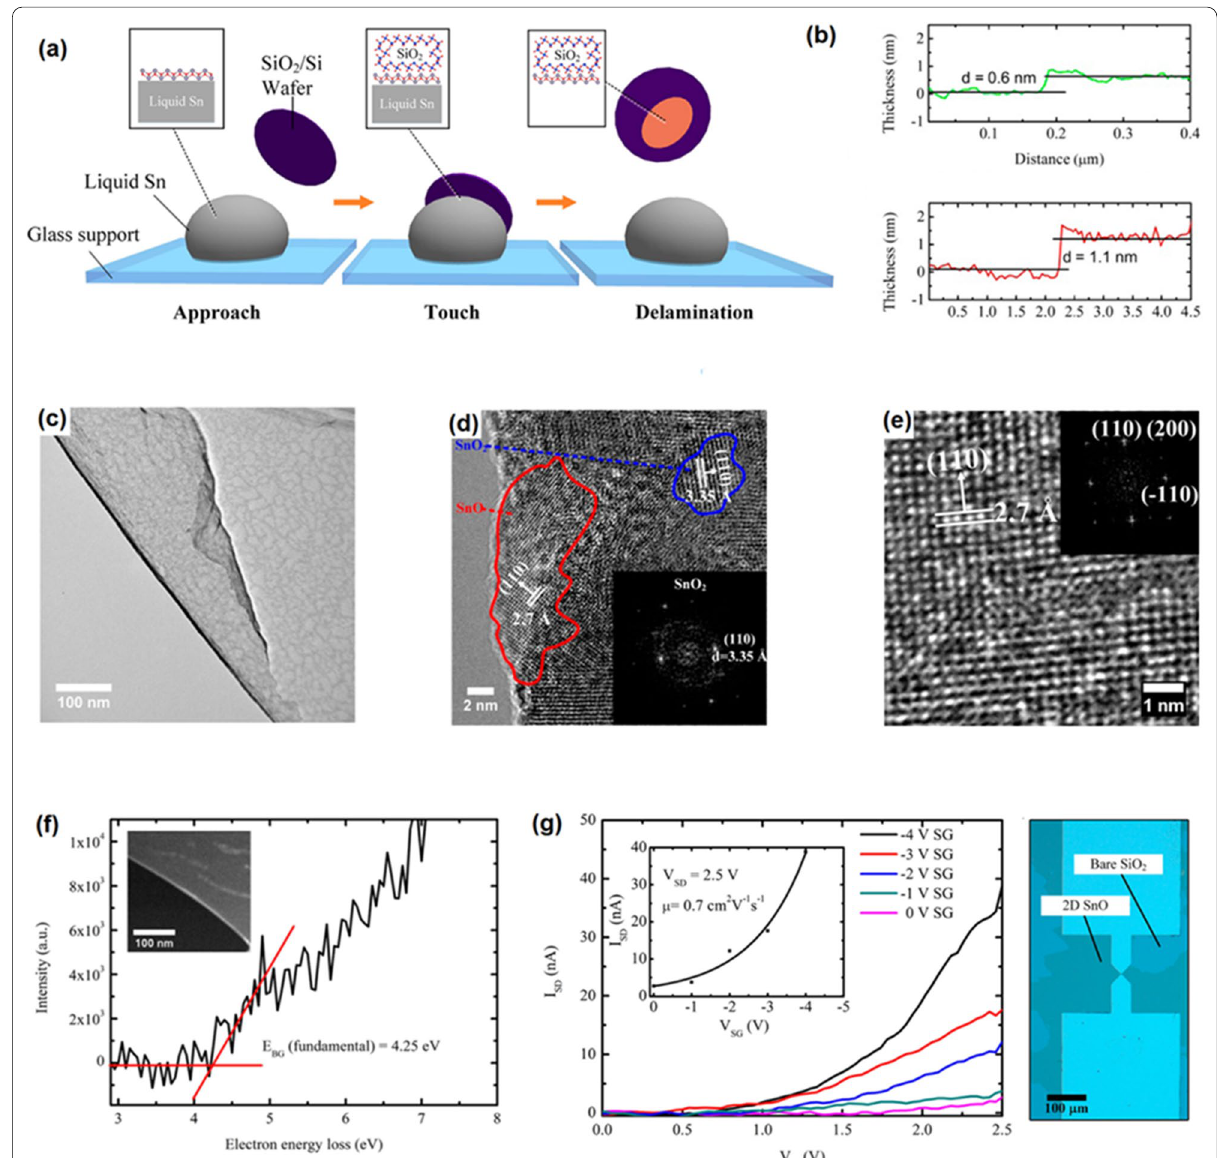
Fig. 10 a Graphical representation of vdW exfoliation method. When a Si/SiO 2 substrate is attached to the molten tin alloy, the created vdW force between the tin oxide and SiO 2 surface help to delamination and following attachment of 2D oxide film to the SiO 2 substrate. b The AFM image of the monolayer (0.6 nm) and bilayer (1.2 nm) tin oxide film. c The TEM image of tin oxide film developed in controlled atmosphere. d The HRTEM of tin oxide film developed in ambient atmosphere with mixed SnO and SnO 2 structure. e The HRTEM image of SnO film developed in controlled atmosphere. f The bandgap of monolayer SnO film measured by electron energy loss spectroscopy. g The I-V characteristics of fabricated SnO FET device at various gate voltages. Reprinted with permission from